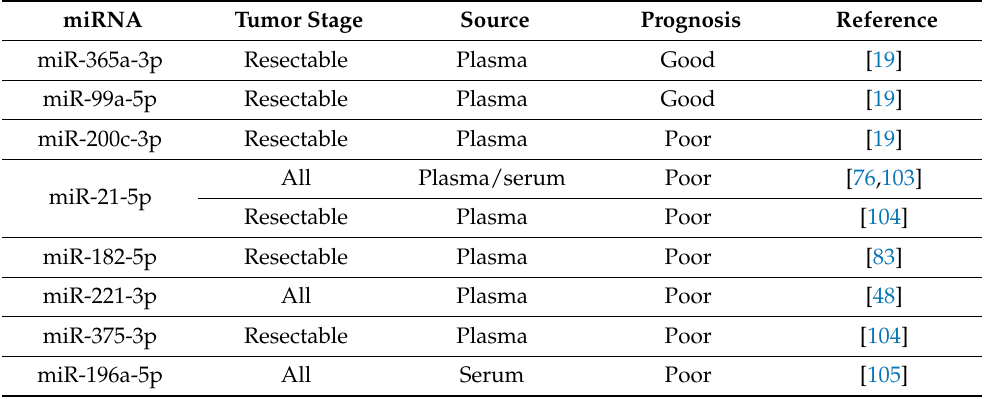
Table 2. Circulating miRNAs with higher levels and prognostic significance in early-stage PDAC. miRNA Tumor